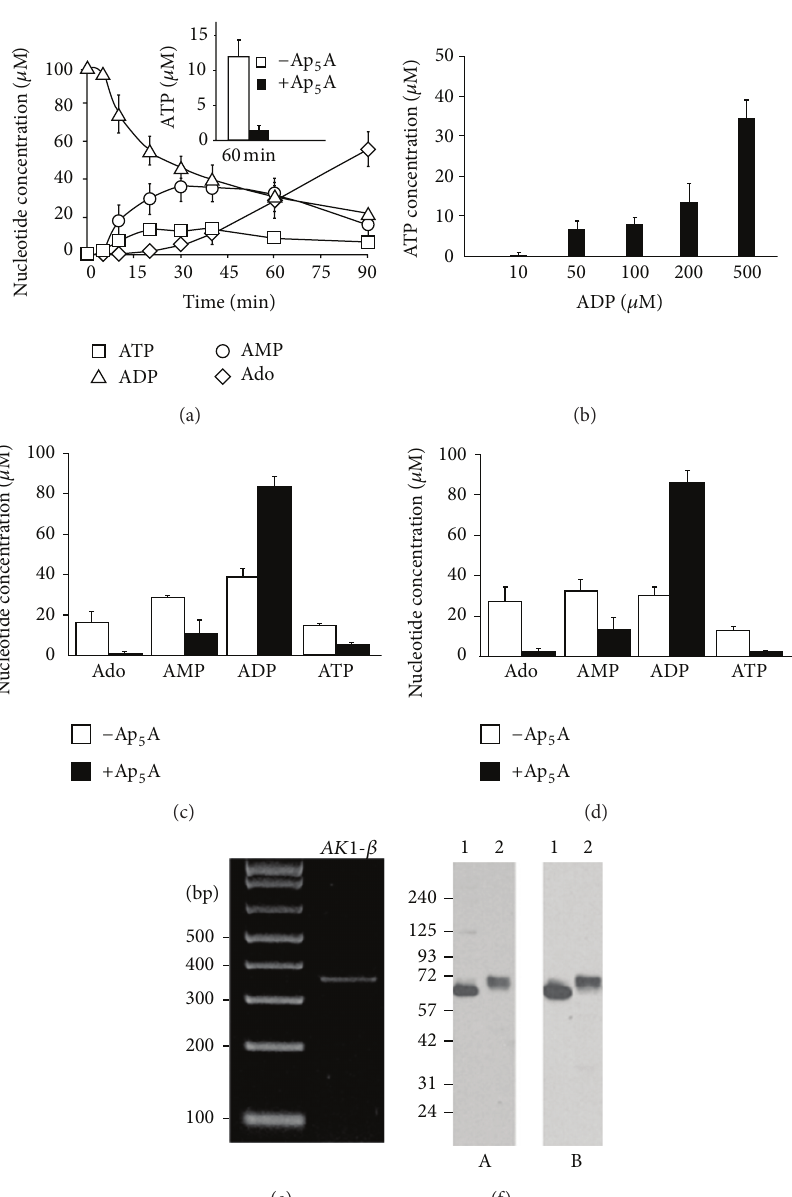
Figure 2: Adenylate kinase and ecto-5 󸀠 -nucleotidase are expressed by HT-29 cells. (a) HT-29 cells were incubated with ADP for 90 min and their supernatants were subjected to RP-HPLC for the determination of purines and ADK activity ( 𝑛 = 3 ). Inset shows the effect of the ADK inhibitor, Ap 5 A, on ATP production by HT-29 cells after 1 h ( 𝑛 = 3 ). (b) Supernatants from HT-29 cells incubated for 30 min with various concentrations of ADP were subjected to RP-HPLC to determine ATP production ( 𝑛 = 3 ). ((c), (d)) Supernatants from HT-29 cells incubated for 30 min with either 100 𝜇 M ATP ((c) 𝑛 = 2 ) or ADP ((d) 𝑛 = 3 ), in the presence of 10 𝜇 M Ap 5 A or control vehicle, were subjected to RP-HPLC for the determination of adenine nucleotide and adenosine byproducts. (e) Semiquantitative RT-PCR analysis on HT-29 cell line showing the presence of the membrane associated adenylate kinase. A representative experiment of 𝑛 = 2 is presented. (f) The expression of ecto-5 󸀠 -nucleotidase protein was detected by immunoblotting with the rabbit anti-human ecto-5 󸀠 -nucleotidase h5 󸀠 NT- 2 side) and with the commercial antibody clone 4G4 ((B) on right side). For panels (A) and (B), lane 1 represents the positive control of protein extract (6 𝜇 g) from HEK 293 cells transiently transfected with a human ecto-5 󸀠 -Nucleotidase expression vector and lane 2 protein extract (20 𝜇 g) from